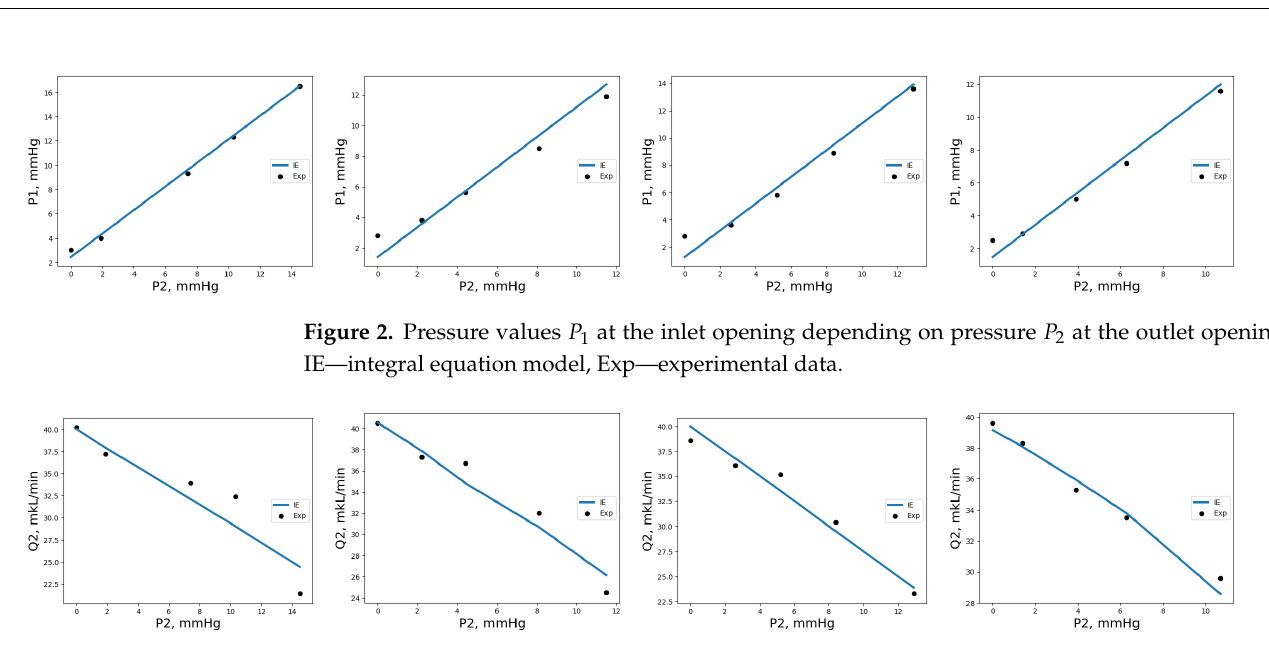
Figure 3. Flow values Q 2 at the outlet opening depending on pressure P 2 at the outlet opening. IE—integral equation model, Exp—experimental